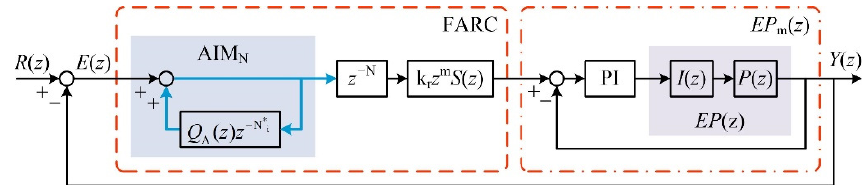
Figure 5. Schematic diagram of the control system.